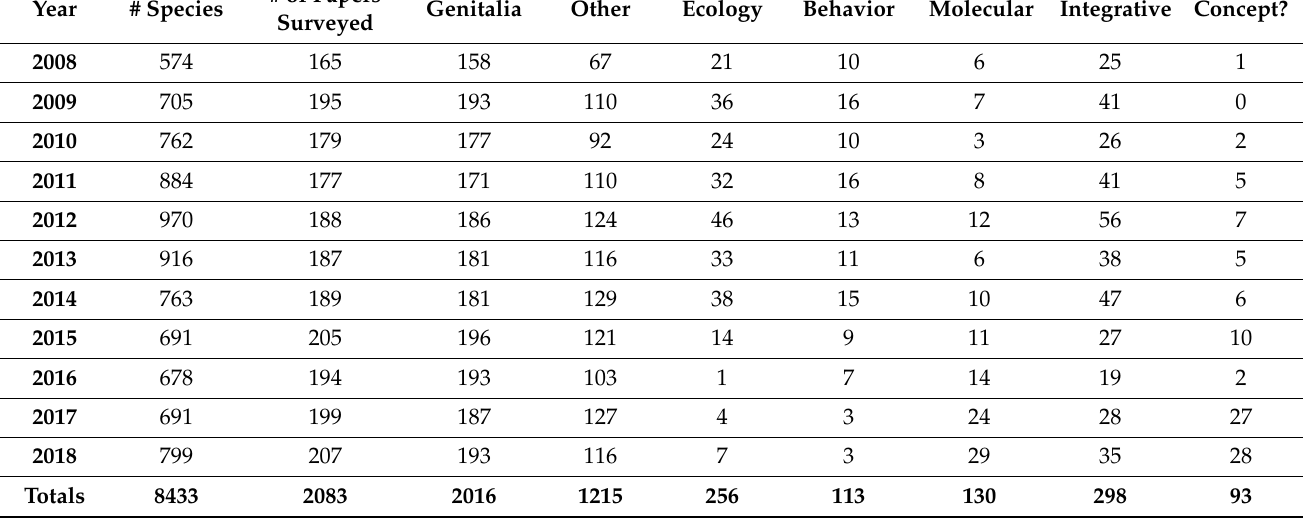
Table 2. The 2008–2018 summary data showing numbers of species described, numbers of papers examined, types of data considered, numbers of studies scored as integrative, and the number of papers that communicated an explicit species